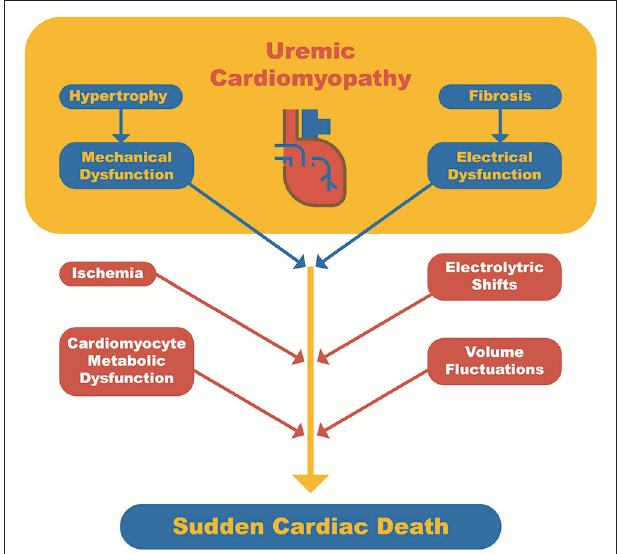
FIGURE 1 | Schematic representation of sudden cardiac death pathophysiology in dialysis patients. Uremic cardiomyopathy serves as the arrhythmogenic substrate and triggers related to dialysis or cardiomyocyte metabolism may lead to a fatal arrhythmia.